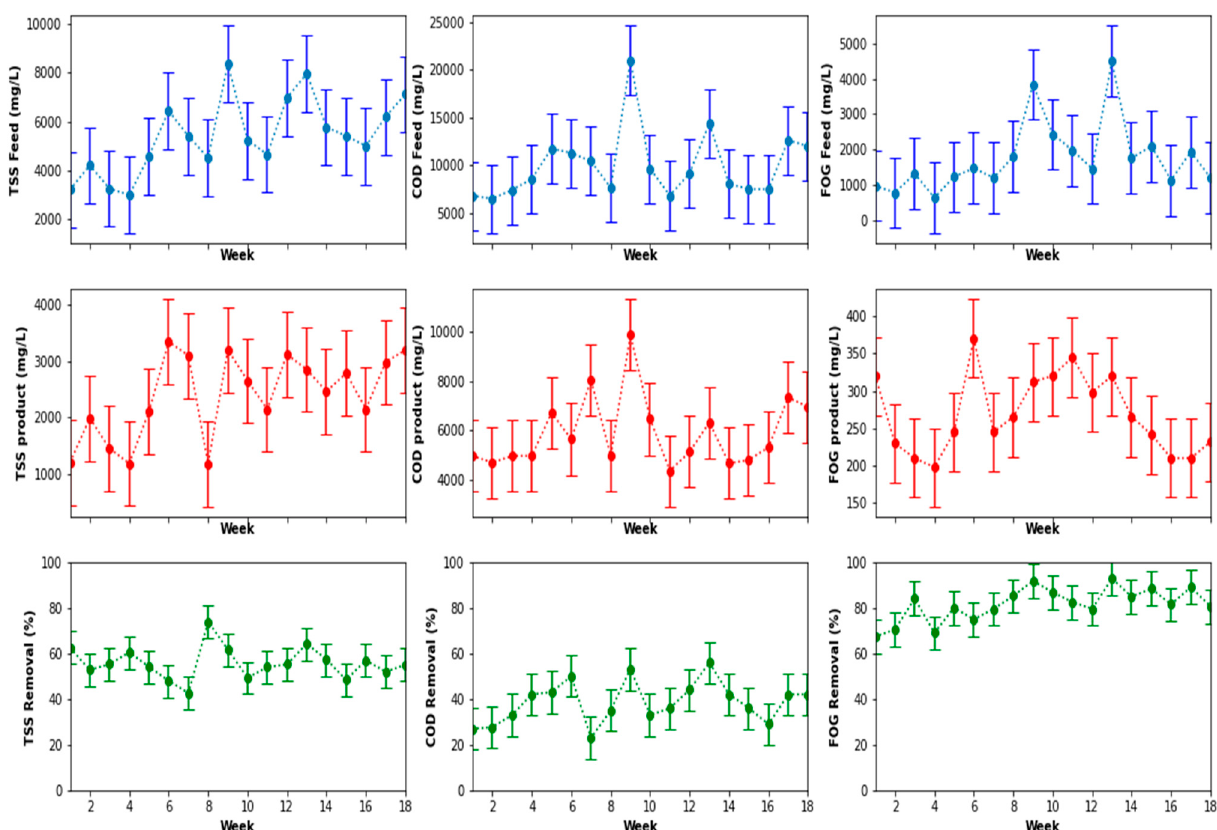
Figure 4. Performance of the pre-treatment unit before outlier replacement.